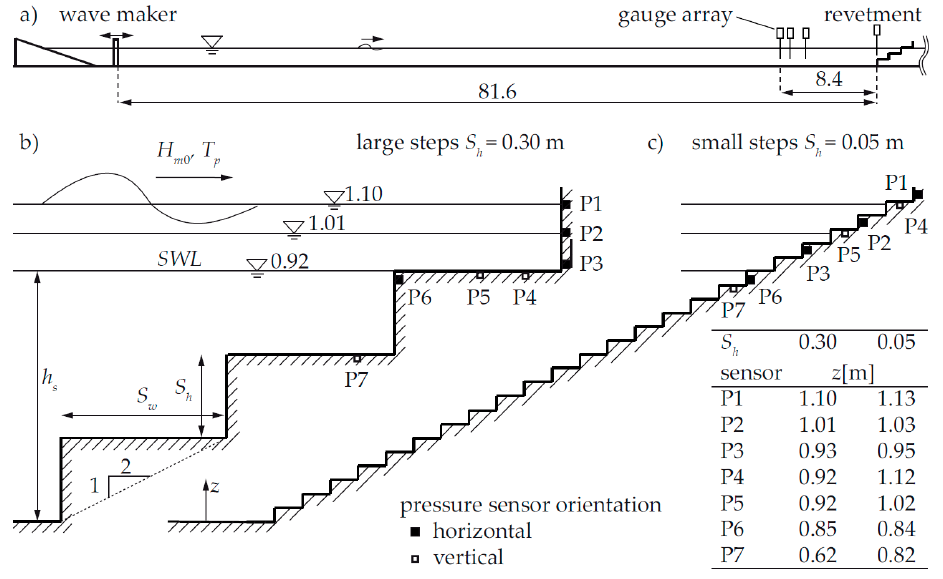
Figure 1. Model set-up of pressure sensors and position of the SWL for two 1:2 inclined stepped revetments. ( a ) Cross-section of the flume set-up, ( b ) detail of the large step configuration ( S h = 0.3 m), and ( c ) detail of the small step configuration ( S h = 0.05 m).